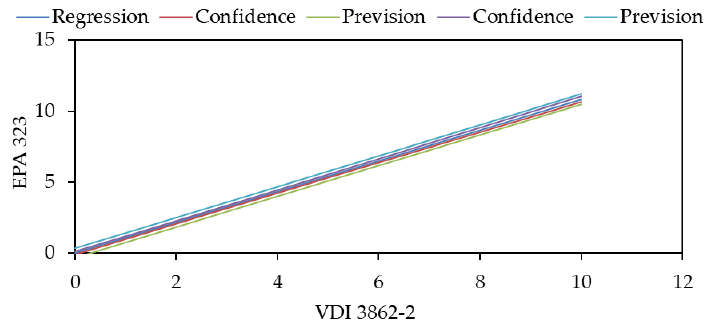
Figure 8. Linear correlation between EPA 323 analysis from Lab. APPA Trento and VDI 3862-2